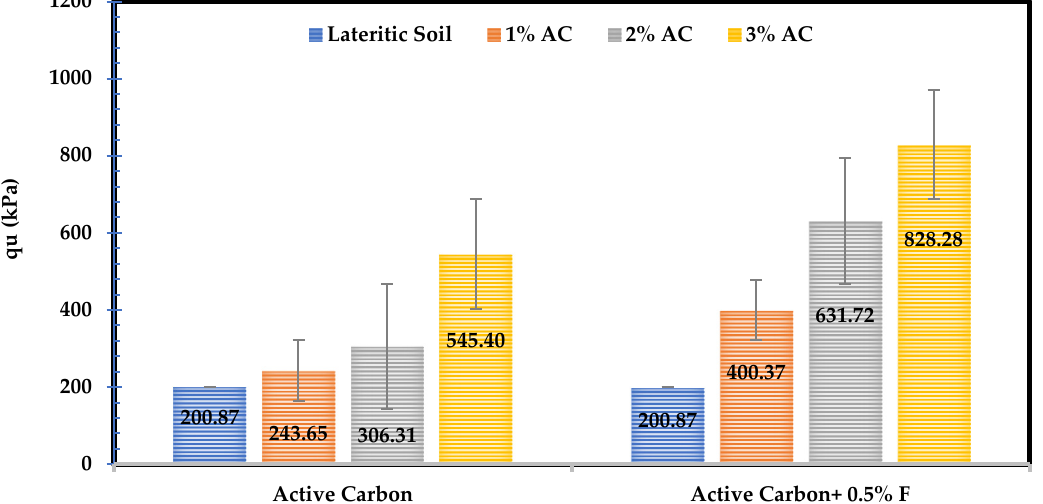
Figure 5. The compressive strength value of AC- and ACF-treated soil.